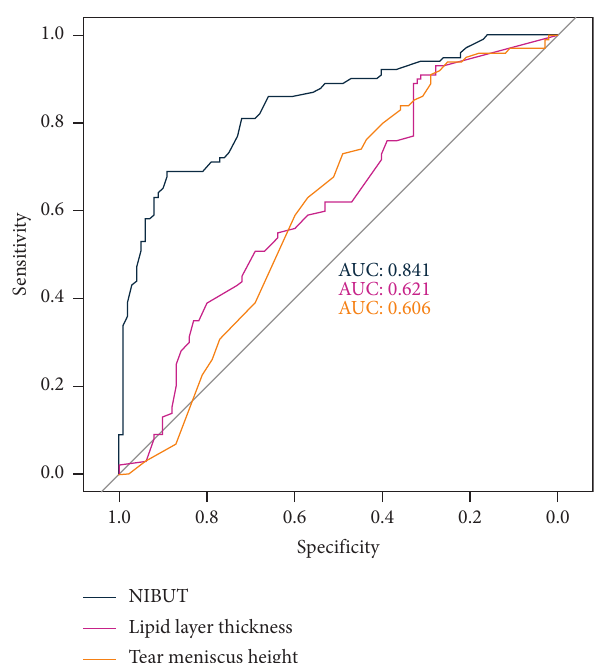
Figure 2: Receiver operating characteristic curves with area under the curve of noninvasive breakup time, lipid layer thickness, and tear meniscus height for the diagnosis of dry eye